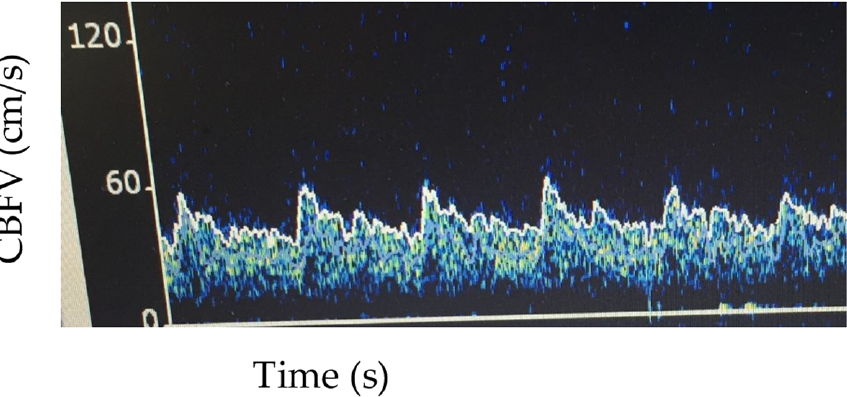
Figure 2. Example of MCA low flow pattern. Vs: 55 cm/s, Vm 42 cm/s, Vd 33 cm/s, pulsatility index 0.54. Similarly, in a study of children with cerebral malaria, TCD patterns were identified as hyperemia (Vm ≥ 2 SD from normative, Lindegaard Ratio < 3, and absent dicrotic notch on waveform analysis), low flow (Vd/Vs/Vm all < 2 SD below normative and PI < 1.2), microvascular obstruction (Vs normal, Vd < 2 SD from normative, and PI ≥ 1.2), cerebral vasospasm (Vm ≥ 2 SD from normative, Lindegaard Ratio ≥ 3, and dicrotic notch present on waveform analysis), and isolated posterior hyperemia (Vm in the basilar artery ≥ 2 SD from normative and Vm in the MCA was normal) [23]. Of the 160 children with cerebral malaria, 35 (22%) had microvascular obstruction, 42 (26%) had hyperemia, 21 (13%) had vasospasm, 46 (28%) had low flow, 7 (4%) had isolated posterior hyperemia, and 5 (3%) had normal flow. Children with low flow were most at risk to die [23]. These identified patterns may provide guidance to the clinician for potential therapeutic